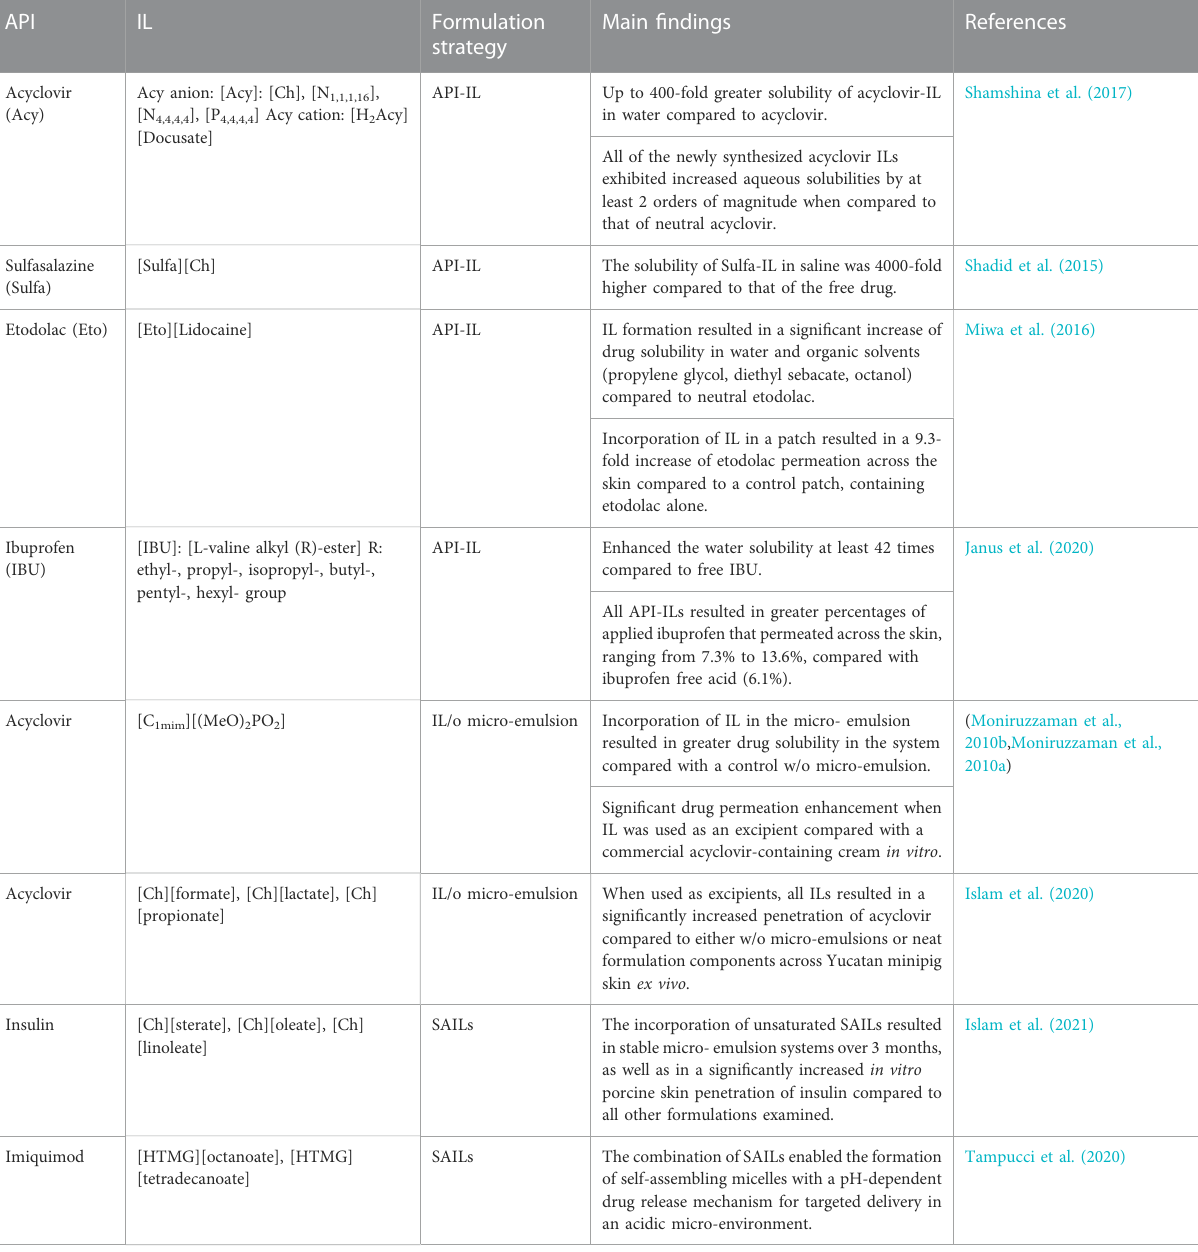
TABLE 1 IL-based formulation strategies for the development of topical and transdermal